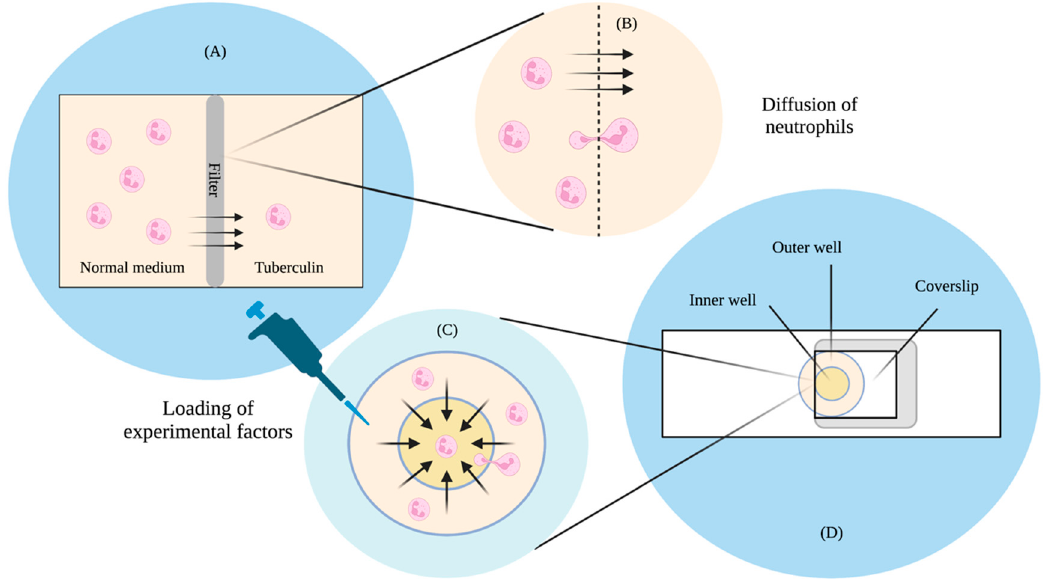
Figure 1. Simplistic adapted diagram highlighting: ( A ) the chemotaxis of neutrophils from the normal medium to tuberculin through a filter in the Boyden chamber; ( B ) the diffusion of neutrophils in the Boyden chamber; ( C ) the loading of experimental factors in the Zicha chamber; and ( D ) the Zicha chamber incorporating the Helber bacteria counting chamber and the diffusion of cells from an outer well to an inner well under a coverslip. Arrows indicate the direction of cell flow. Created with BioRender.com (https://app.biorender.com/). Last accessed on 29 September 2022.